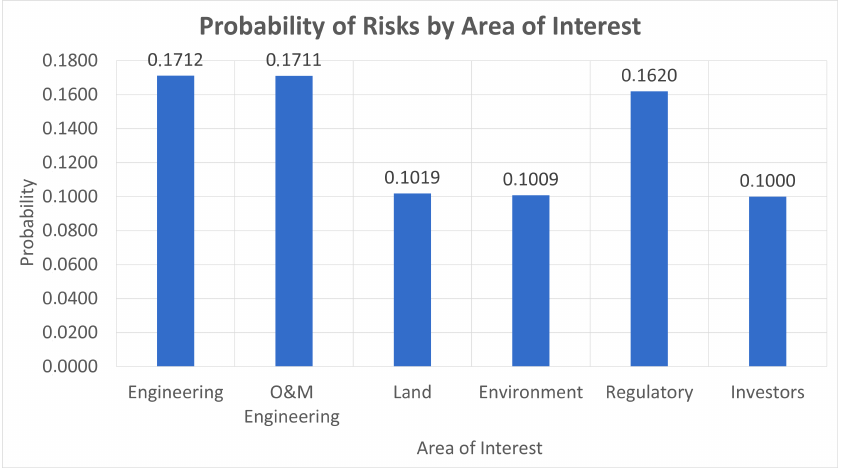
Figure 7. Risk probability per area. Those areas are engineering, O&M engineering, land, environ- ment, regulatory, and investors. This accounts for the average risk probability for all risks that fall within each particular area.